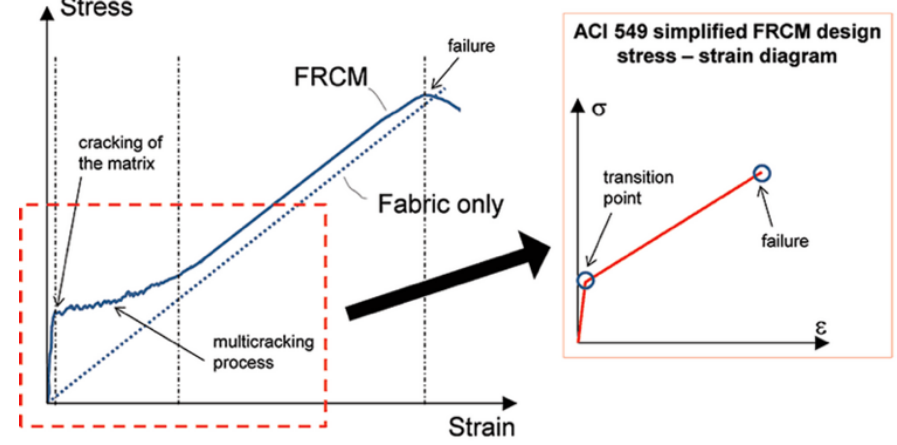
Figure 4. Stress-strain behavior of the FRCM system [8]. Reproduced with permission from [8],